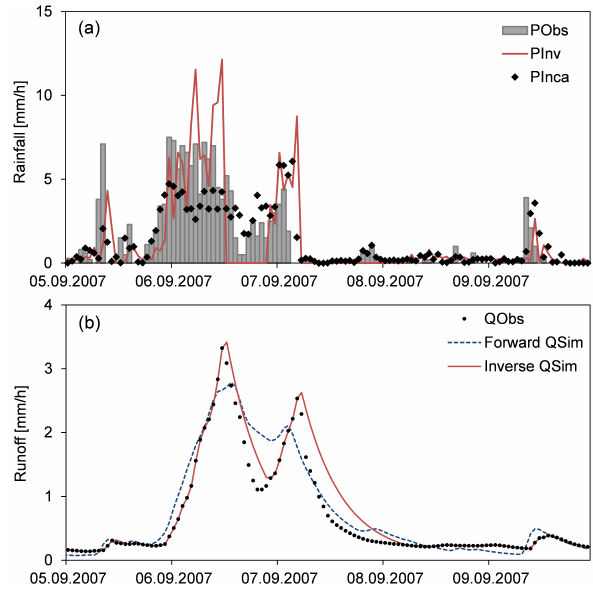
Figure 11. Krems catchment: temporal development of the different rainfall realisations (a) and runoff (b) for a flood event. Simulations originate from Exp 3 .